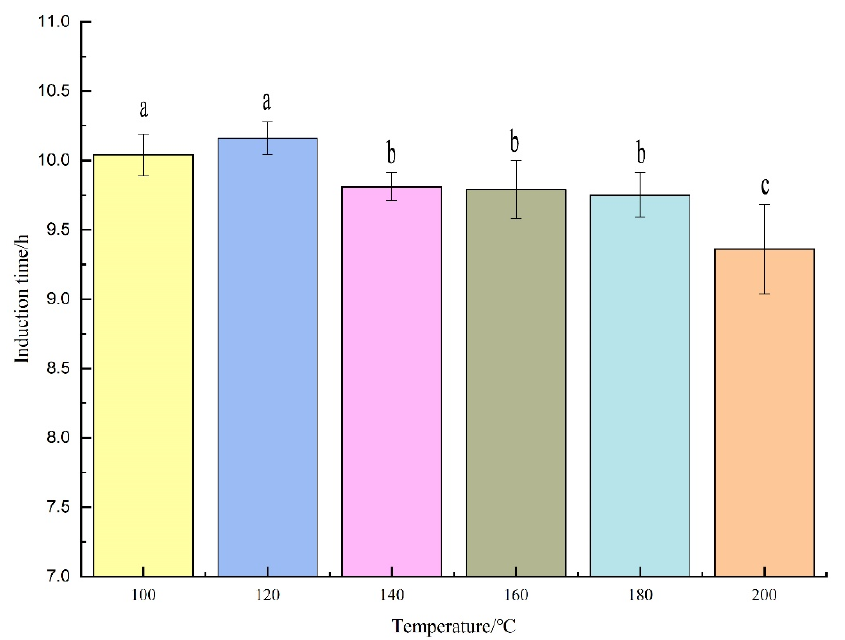
Figure 3. Induction time of cashew nut kernel oil obtained from different pressing temperatures. Note: Different letters a, b and c represented significant differences.